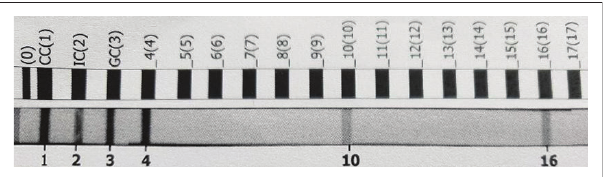
FIGURE 2: Line probe assay (GenoType Mycobacterium CM version 2.0) for patient J.M., from sputum culture, collected 18/11/2019. The conjugate control (CC), internal control (IC) and genus control for mycobacteria (GC) is positive (lines numbered 1, 2, 3). Mycobacterium avium is identified (line 4), as well as Mycobacterium tuberculosis complex (lines 10 and 16). TABLE 3: Microbiological investigations for mycobacterial infection. Specimen type Date of specimen